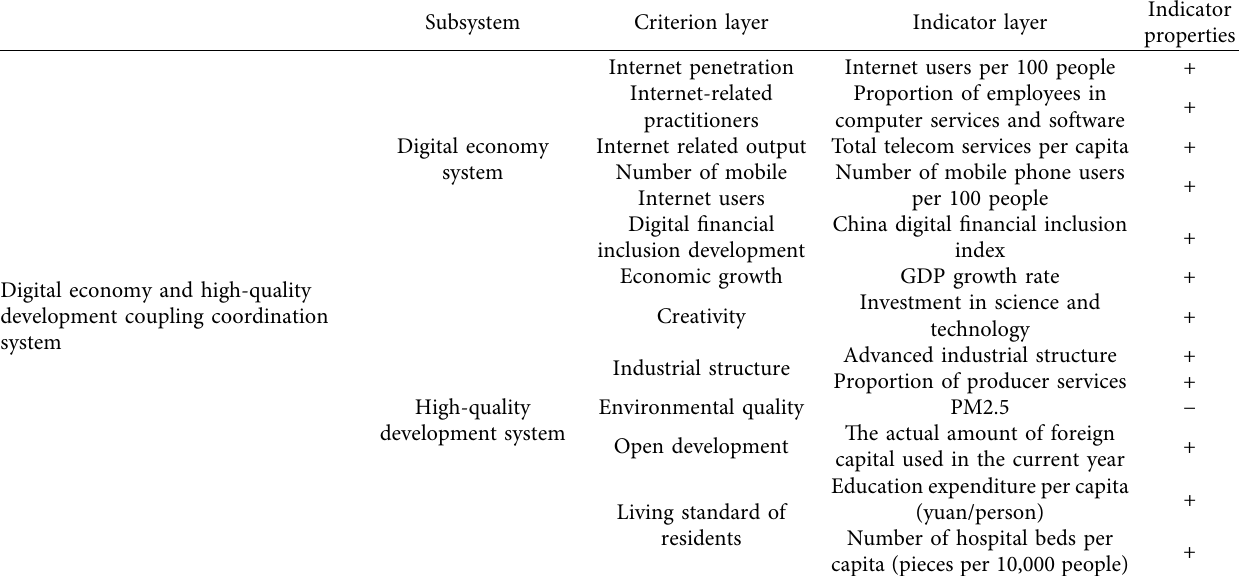
Table 1: Indicator system of digital economy and high-quality